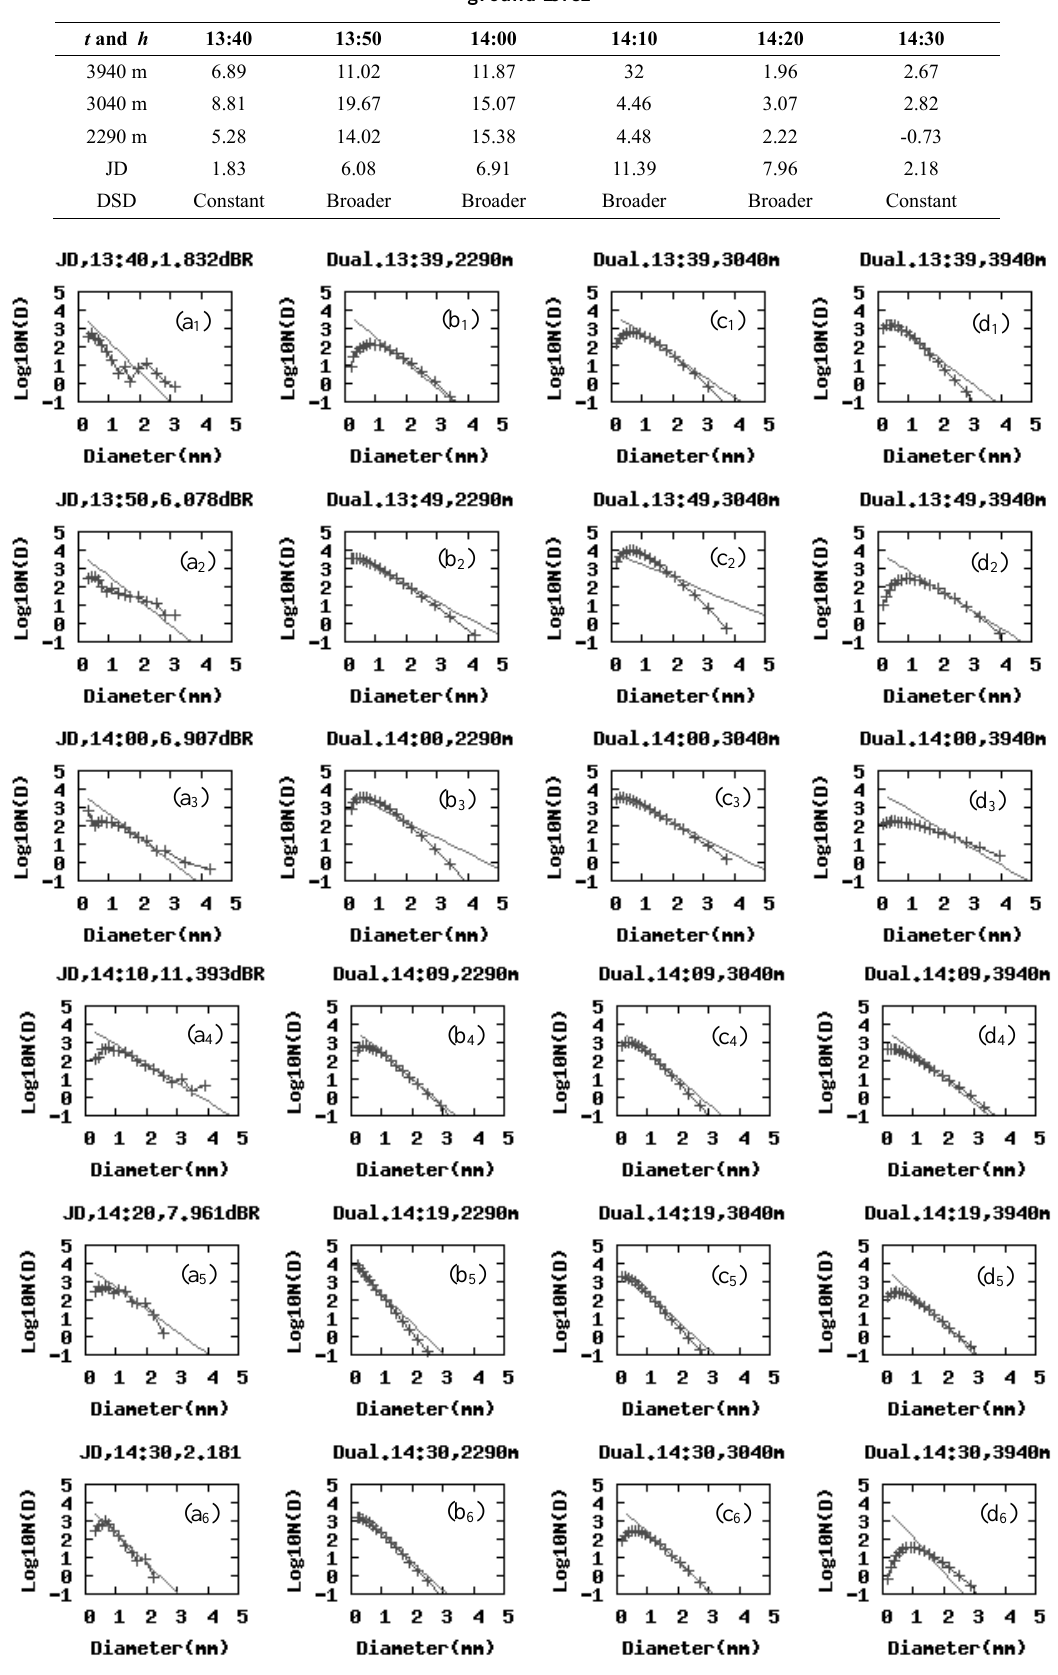
Figure 4. Comparison of DSD results from Joss-disdrometer (JD) and dual-frequency algorithm with the Marshall-Palmer (MP) DSD model at several heights from 13:40 – 14:30 on April 23, 2004. Straight line is DSD of the MP